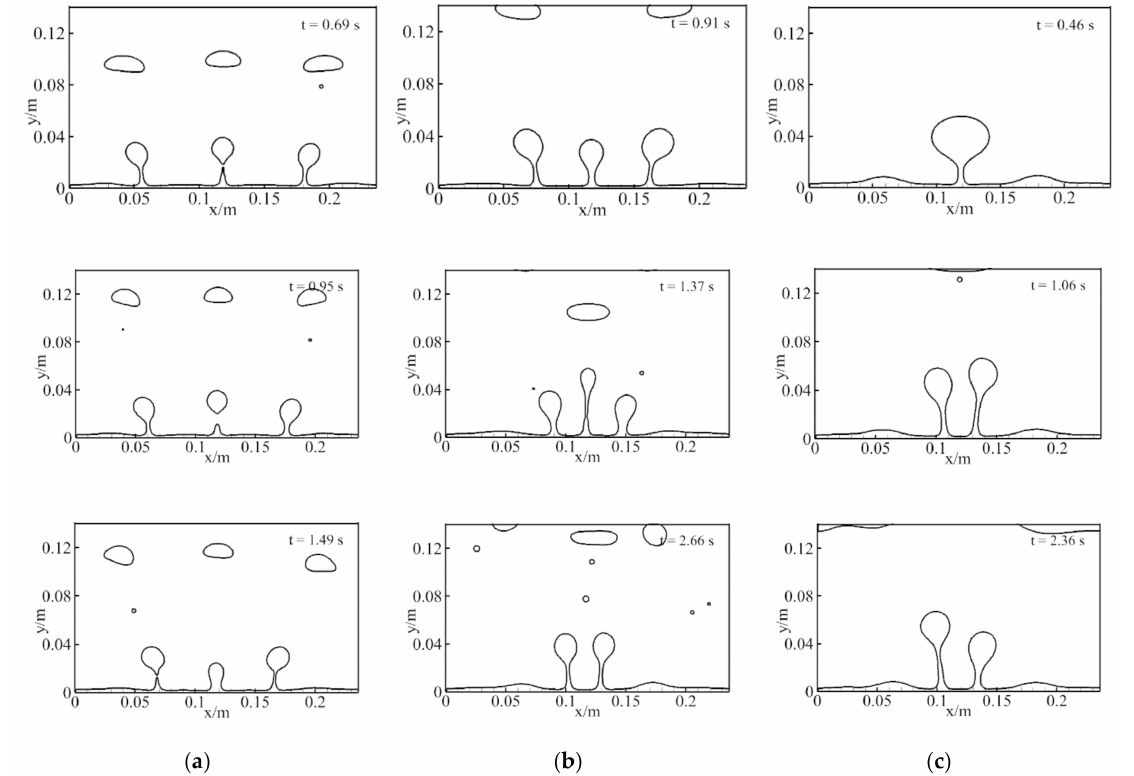
Figure 13. The bubble detachment at different gravity levels when H 0 = 20 kA/m. ( a ) g / g e = 1.0, ( b ) g / g e = 0.44, and ( c ) g / g e =